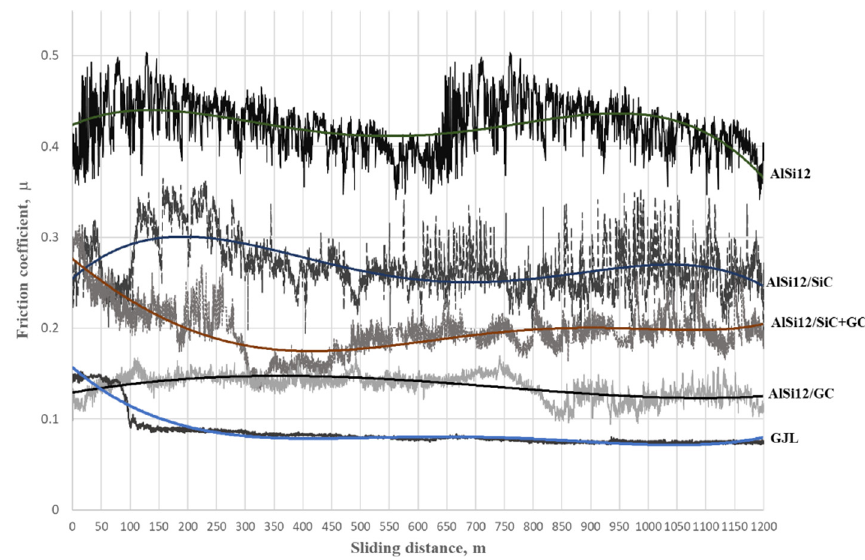
Figure 7. Friction coefficient ( μ ) versus sliding distance for the tested materials; the change of the trend for the tested materials was marked with continuous lines.